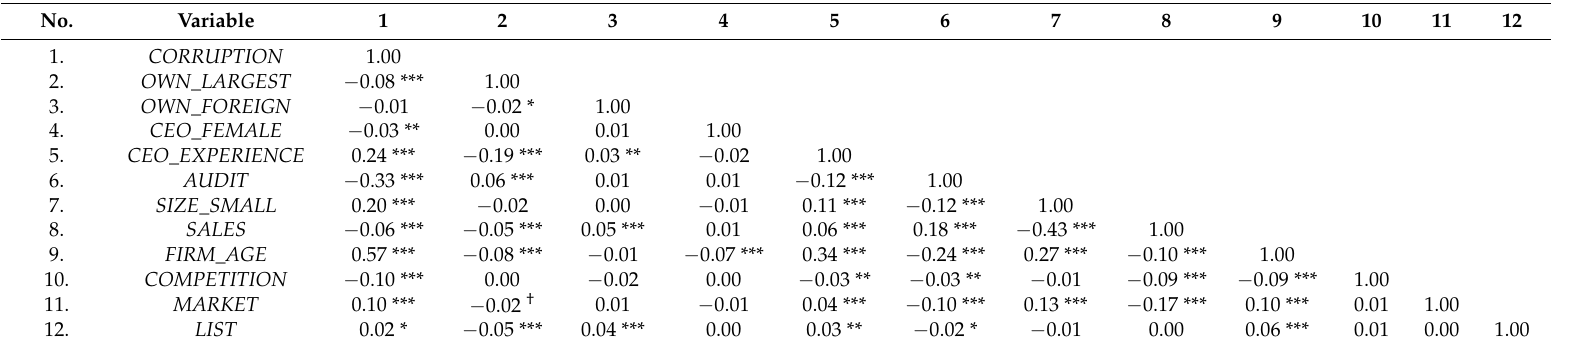
Table 5. Correlation Matrix (Total Observations =